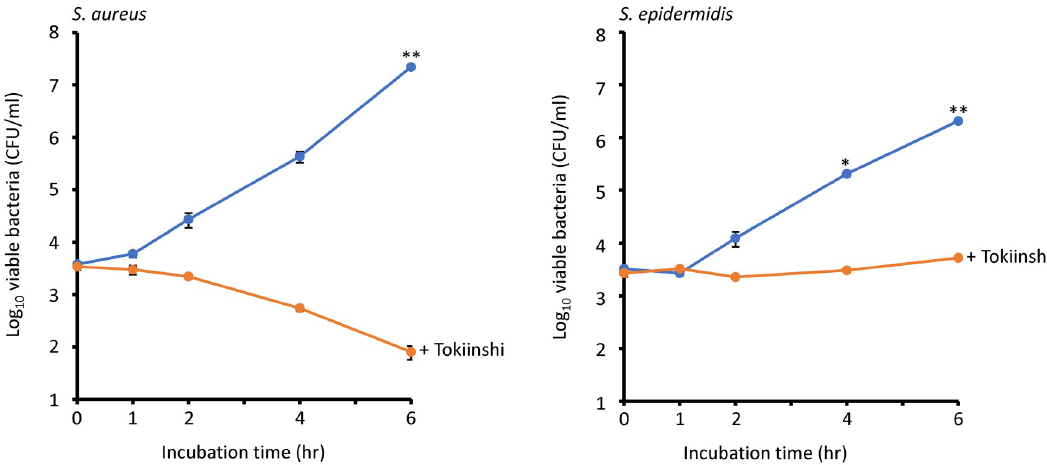
Fig 1. Growth inhibition effect of Tokiinshi (20 mg/ml) against S . aureus and S . epidermidis . � P < 0.05, �� P <